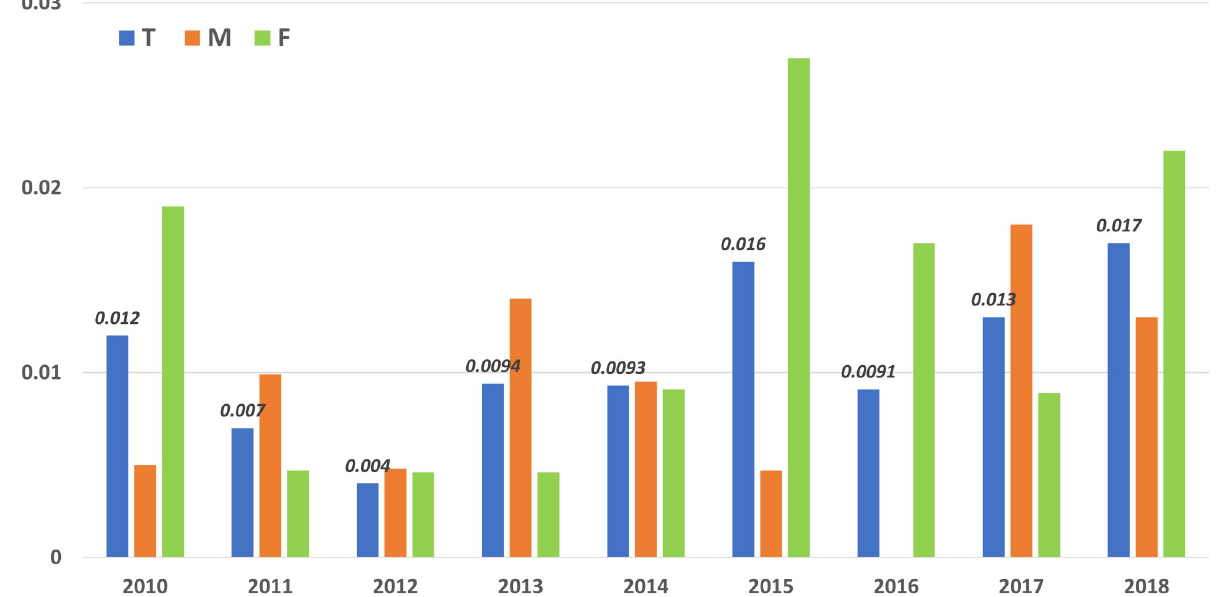
Fig 3. Argentina: Total mortality rate per sex in patients over 15 years old in 2010–2018. GBD Project (metrics provided by the Institute of Health Metrics).